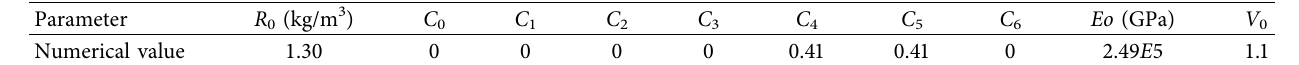
Table 4: Air medium material parameters.